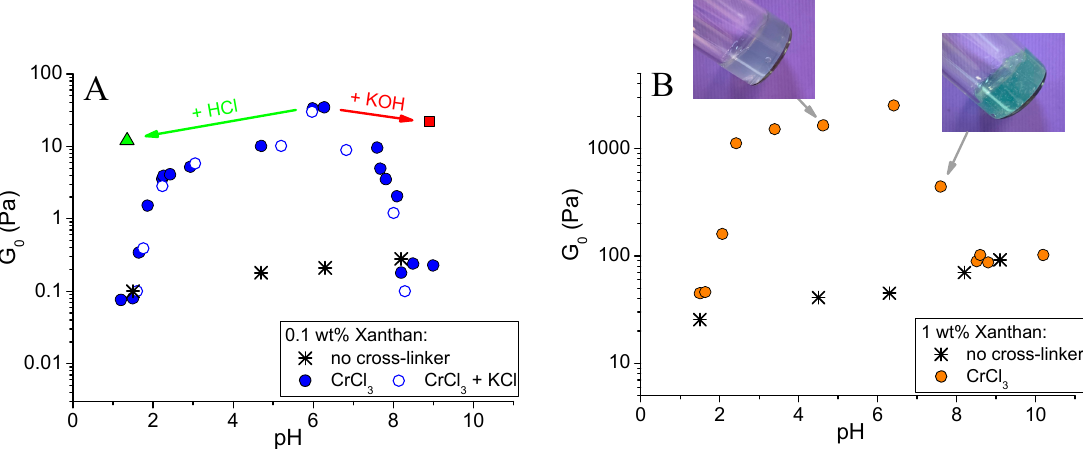
Figure 3. Dependence of the plateau storage modulus G 0 on pH for 0.1 wt % ( A ) and 1 wt % ( B ) xanthan aqueous solutions in the absence of cross-linker (asterisks), in the presence of CrCl 3 at molar ratio [CrCl 3 ]/[xanthan monomer units] = 1 (filled circles), and in the presence of the same CrCl 3 concentration and 4.75 wt % KCl (open circles). A triangle in Figure 3B corresponds to the gel obtained by the addition of 150 μ L of 5 M HCl to the 4 mL gel initially prepared at pH 6.3; and a square corresponds to the gel obtained by the addition of 4.5 μ L of 5 M KOH to the 4 mL gel initially prepared at pH 6.3. The values of G 0 for liquid samples, which do not have a plateau at the dependence G’( ω ), were taken at ω = 1 s − 1 .